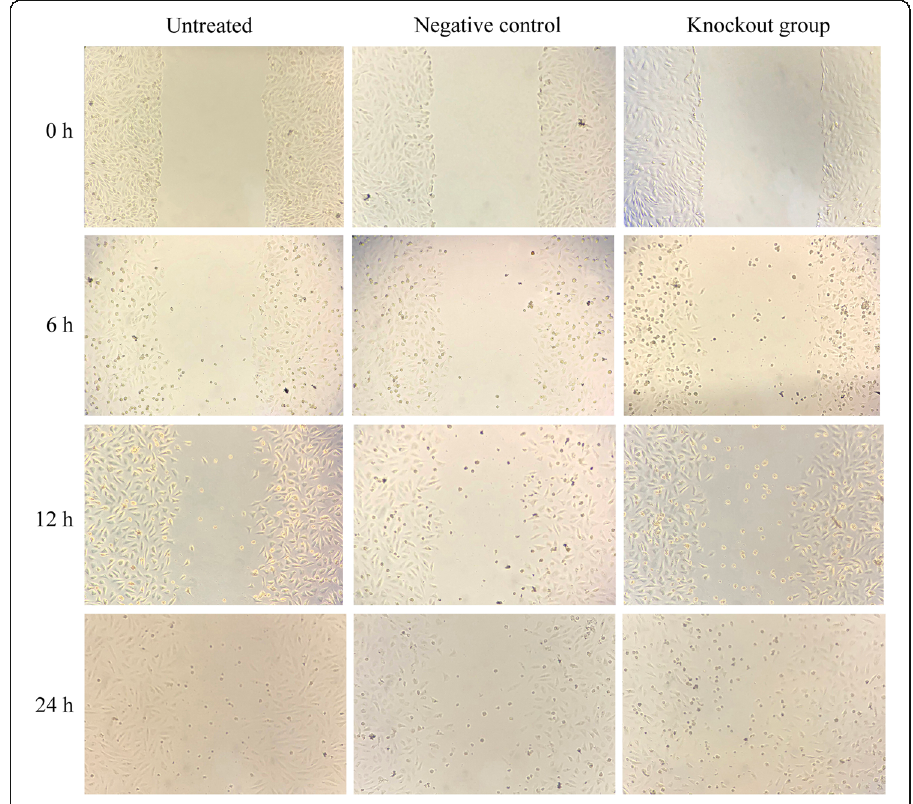
Fig. 4 Cell scratch assay for cartilage cell migration (×